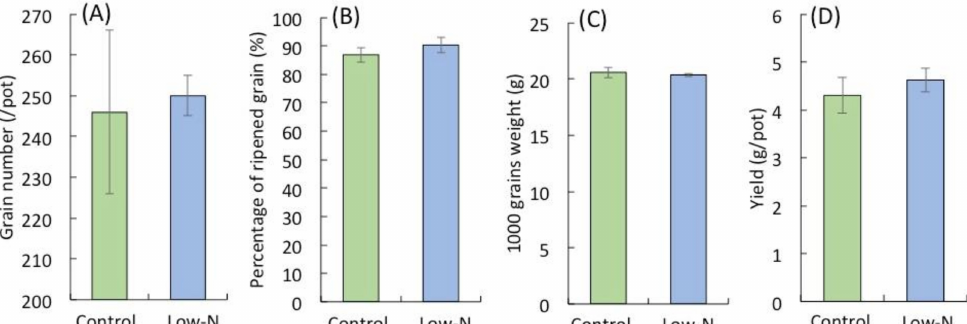
Figure 5. Yield components ( A ), Grain number per pot; ( B ), percentage of ripened grain; ( C ), 1000 grains weight) and yield ( D ). Control and low-N refer plants receive su ffi cient N and 1 / 3 that of the control during seedling stage, respectively. Error bars represent mean ± SD of 5